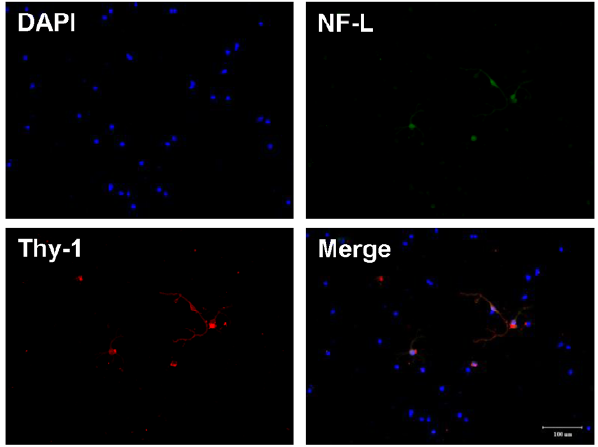
Figure 4. Fluorescence images of dissociated RGCs. Retinal cells were dissociated with papain, fixed with 4% paraformaldehyde in PBS, and stained with DAPI (blue). RGCs (arrowhead) were identified by double immunocytochemistry with anti-neurofilament (NF)-L antibody (green) and anti-thy-1 anitbody (red), bar=100 m m.